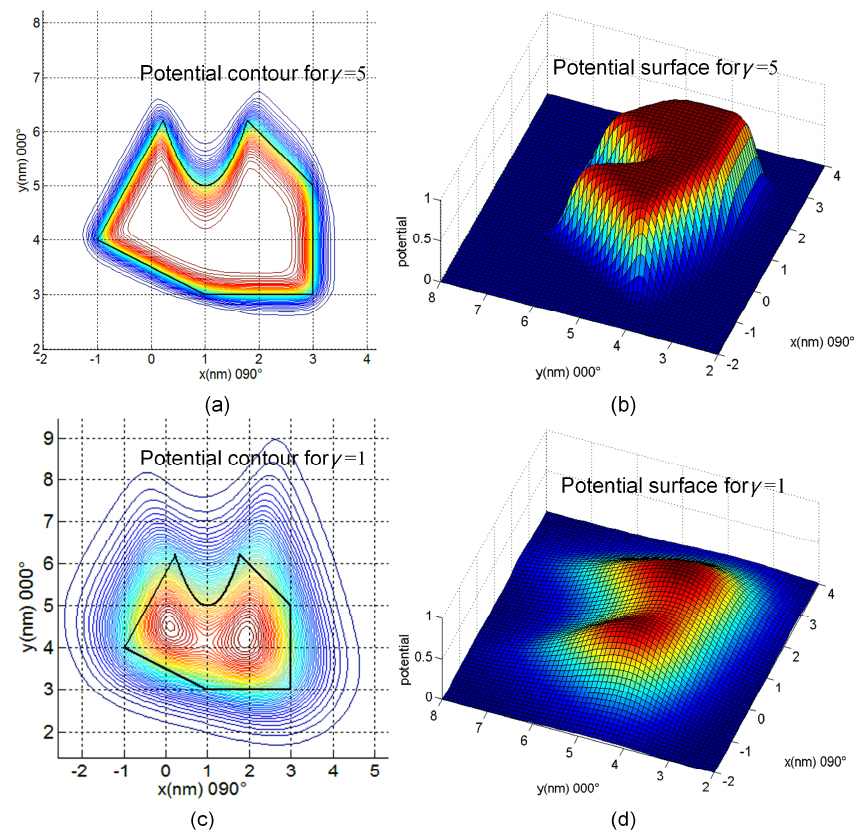
Figure 4. Potential field for a complex face obstacle with different values of parameter γ . ( a ) and ( b ) are potential contours and potential surface for γ = 5 respectively. ( c ) and ( d ) are potential contours and potential surface for γ = 1 respectively.